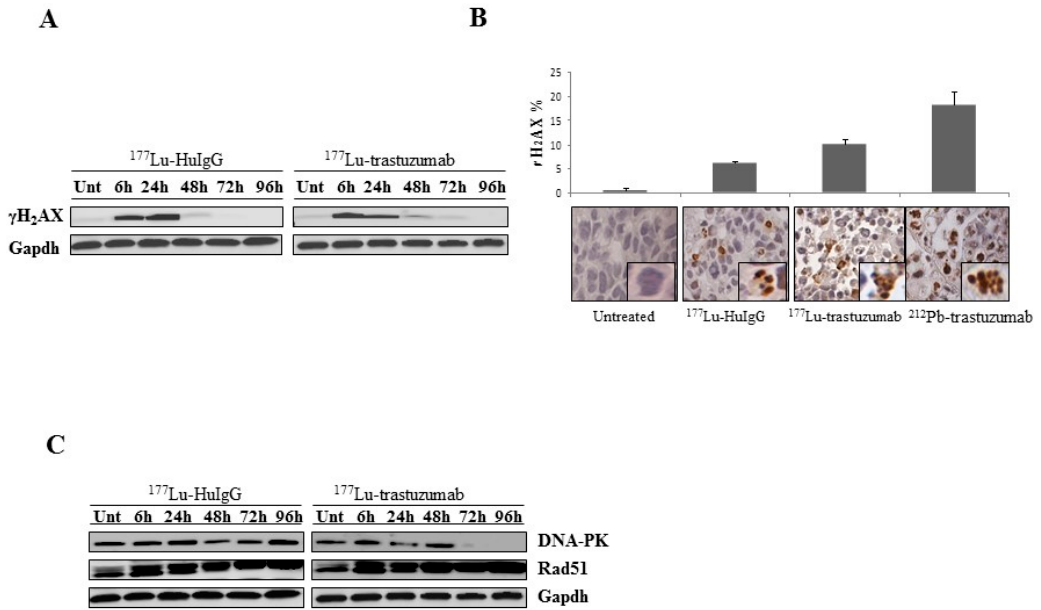
Figure 2. 177 Lu-trastuzumab-induced DNA damage in human colon cancer LS-174T i.p. xenografts. ( A ) Tumor bearing mice were treated with 177 Lu-trastuzumab as indicated and the tumor was collected for 96 h. 177 Lu-HuIgG was included as a non-specific control along with untreated mice. Western blot analysis for γ H 2 AX was conducted and detected at 17 kDa. GAPDH was the equivalent protein loading control; ( B ) Light microscopy image of untreated control, 177 Lu-HuIgG, 177 Lu-trastuzumab, and 212 Pb-trastuzumab. γ H 2 AX was clearly identified on IHC staining compared to the untreated control in tumor tissue 24 h post RIT (40× magnification). The percentage of cells staining positive for γ H 2 AX were plotted. Results represent an average of at least three replications; ( C ) Expression of repair proteins induced by 177 Lu-trastuzumab. Xenograft mice (i.p. LS-174T) were treated with 177 Lu-trastuzumab. Additional groups included untreated and 177 Lu-HuIgG as a non-specific control. Immunoblot analysis for DNA-PK and Rad51 were performed. DNA-PK was detected at 450 kDa. Rad51 was detected at 37 kDa. The equivalent protein loading control was GAPDH.